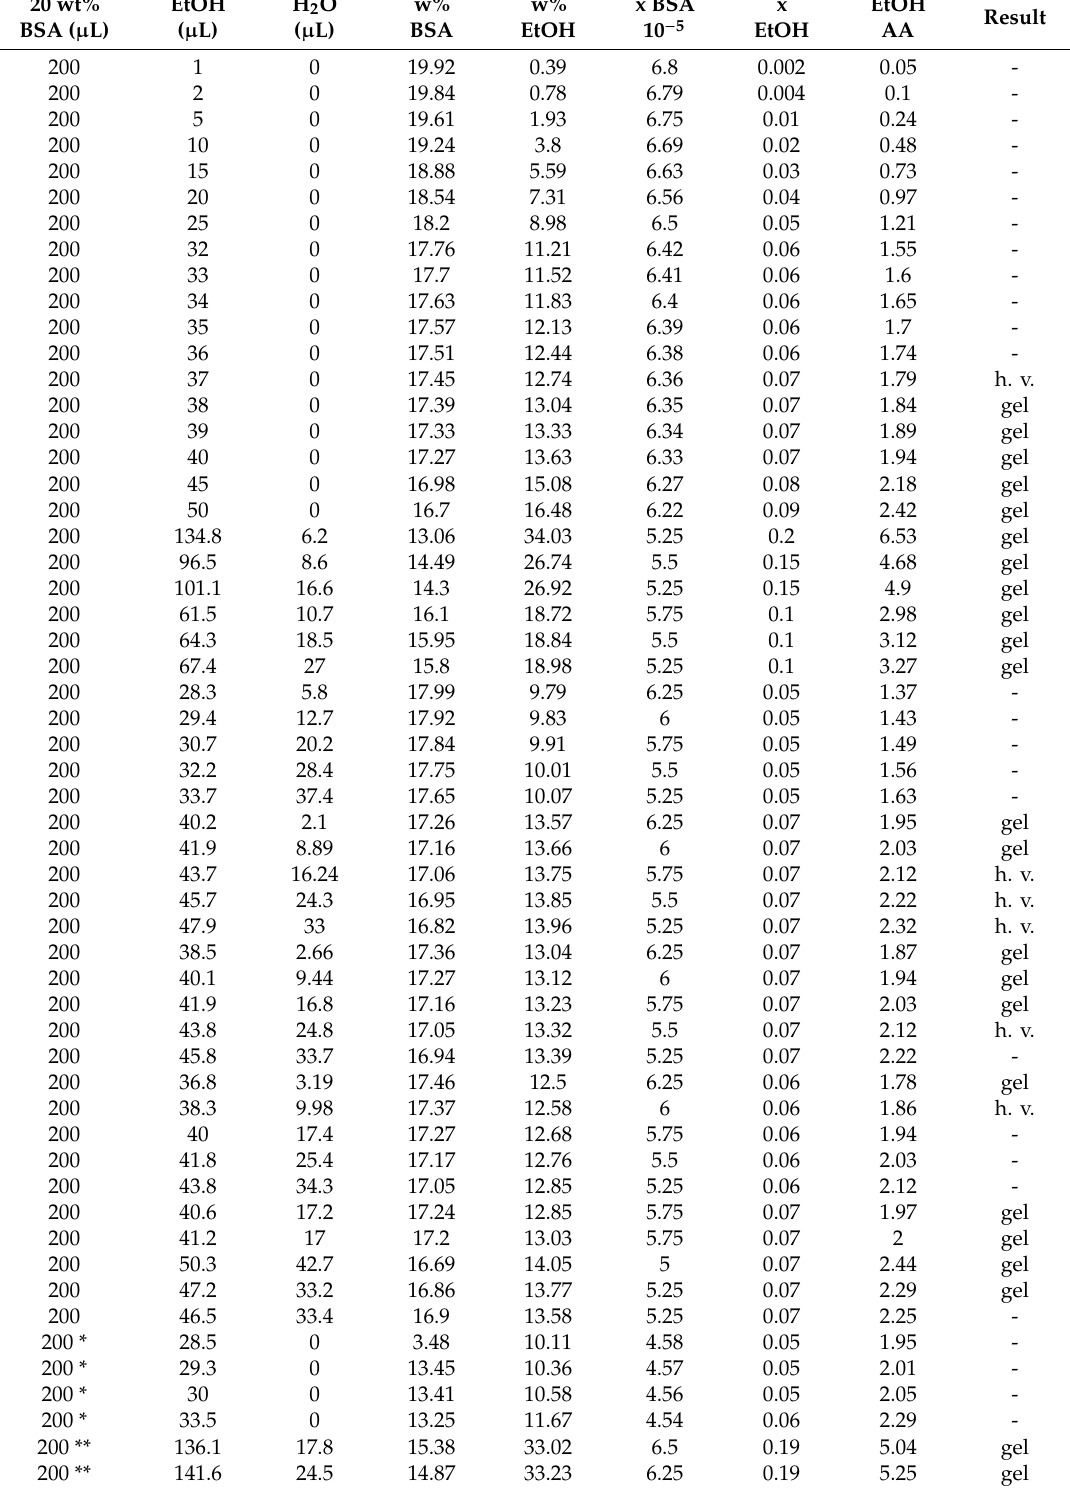
Table A1. Samples and results after 16 h at 37 ◦